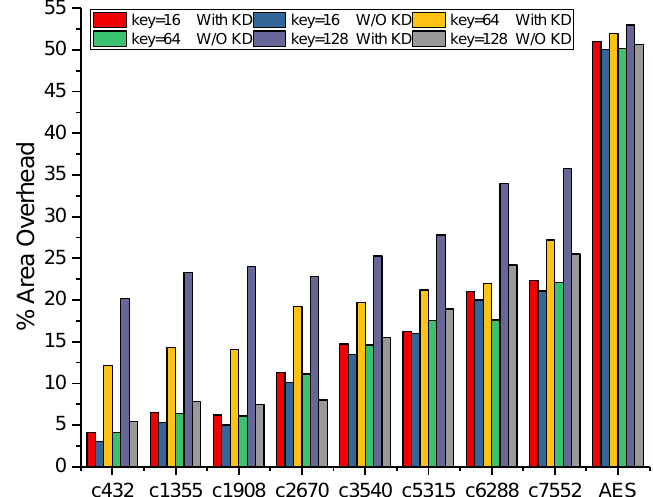
Figure 8. Area overhead for different key-sizes with and without the key interdependency